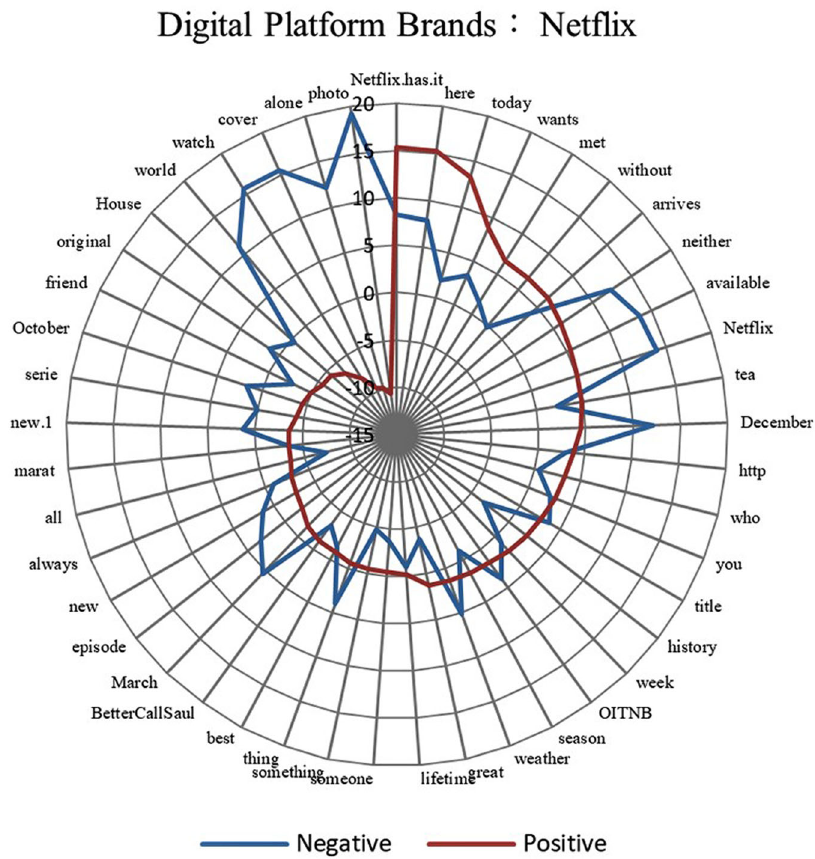
Fig. 7 Cues of Net fl ix, positive and negative clues in the postings on the “ Net fl ix ” fan